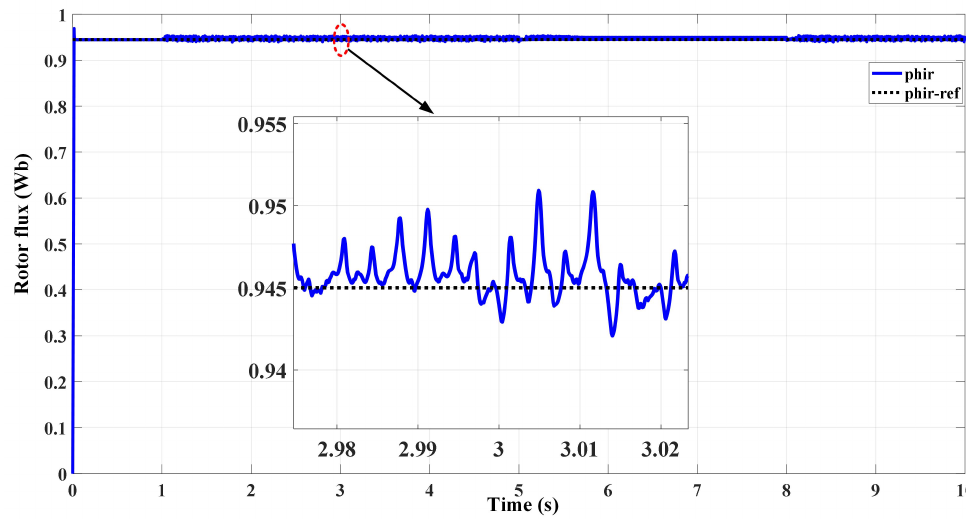
Figure 15. Rotor flux response of the proposed strategy for nominal